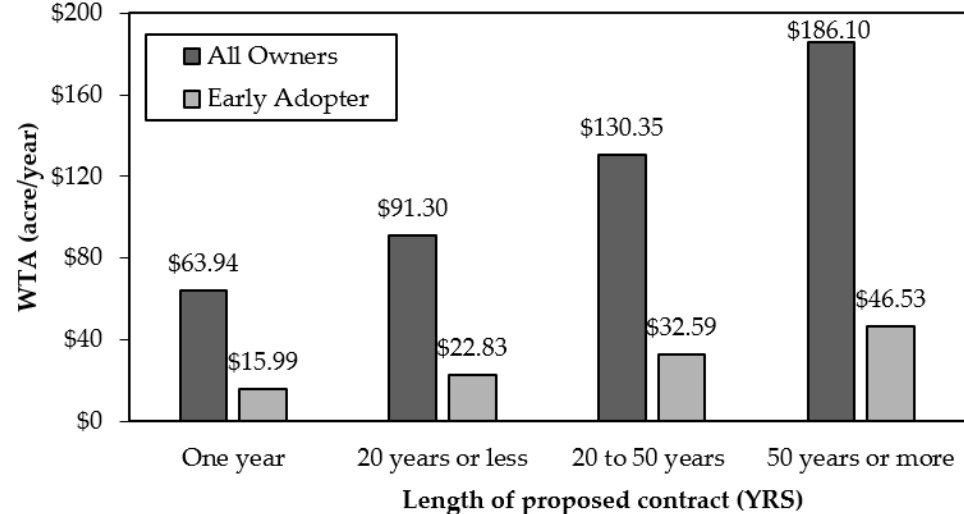
Figure 2. Willingness to accept payment for forest carbon based on contract length (acre/year).